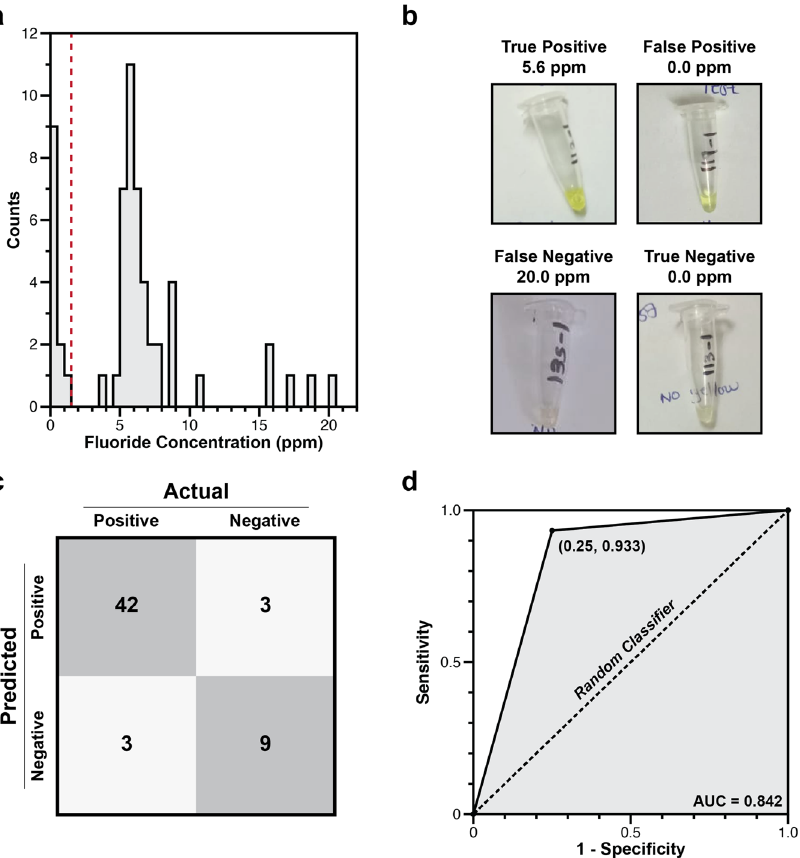
Fig. 2 Fluoride content in 57 samples from 32 households, based on output from the point-of-use biosensor tests and the fl uorimeter. a Distribution of fl uoride concentrations in 57 water samples, as measured by fl uorimeter. The red dashed line indicates the WHO guideline for elevated levels, ≥ 1.5 ppm. b Representative images of true positive, false positive, true negative, and false-negative test results. Photographs are annotated with fl uoride concentrations measured by fl uorimeter. c A confusion matrix of test results. “ Actual ” refers to classi fi cation by fl uorimeter as being positive ( ≥ 1.5 ppm fl uoride) or negative (<1.5 ppm fl uoride). “ Predicted ” refers to biosensor test performance. “ Negative ” means no color change was observed, and “ Positive ” means a yellow color was visible. True positives and true negatives are shaded in gray, while false positives and false negatives are in white. d Receiver-operating characteristic curve derived from classi fi cations in panel c . Sensitivity is calculated as (true positive)/(true positive + false negative) and speci fi city is calculated as (true negative)/(true negative + false